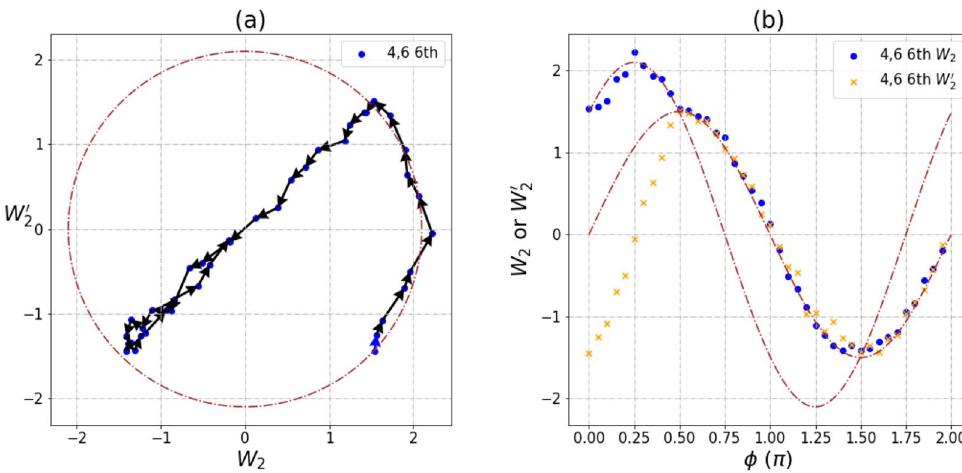
W ′ W 2 and of pair [4,6]. ( a ) The trajectory of 2 (cid:30) (cid:31) W ′ (cid:31) (cid:30) and phase angles φ. The radius of circle is 2.1. The 2 (cid:30)